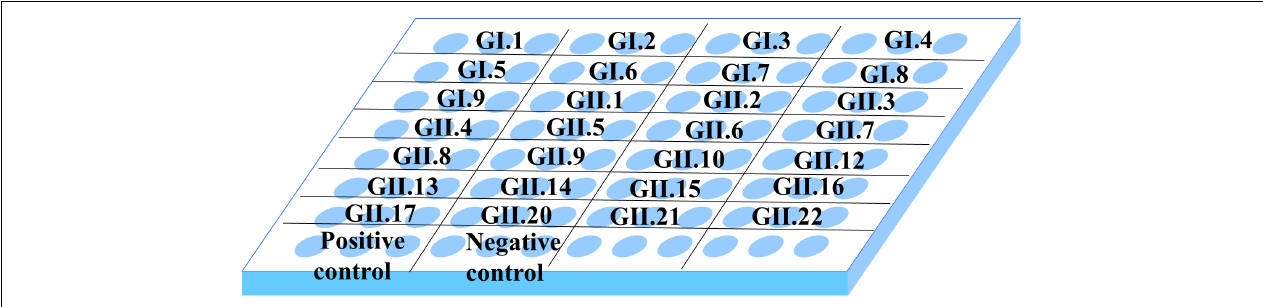
FIGURE 2 | Distribution of antigen coating in 96-well microplate. In the plate, each well was coated with 0.2 µ g P protein, and each P protein was coated with three multiple wells. Wells coated with GST and coating buffer served as positive control and negative control, respectively.